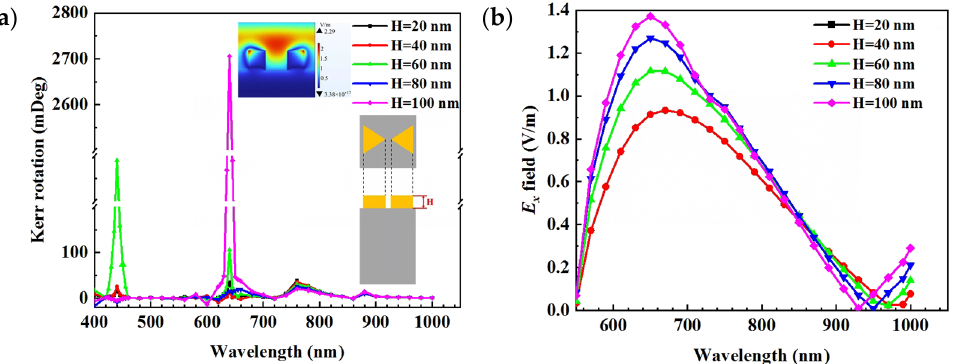
Figure 2. Wavelength-dependent PMOKE response for Au bowties of different height (heights are indicated in the legend). The bowties were located centered within the unit cell of the periodic model. The color subgraph represents the reflected electric field. ( a ) Kerr rotation and ( b ) normalized amplitude of the X component of the reflected electric field.